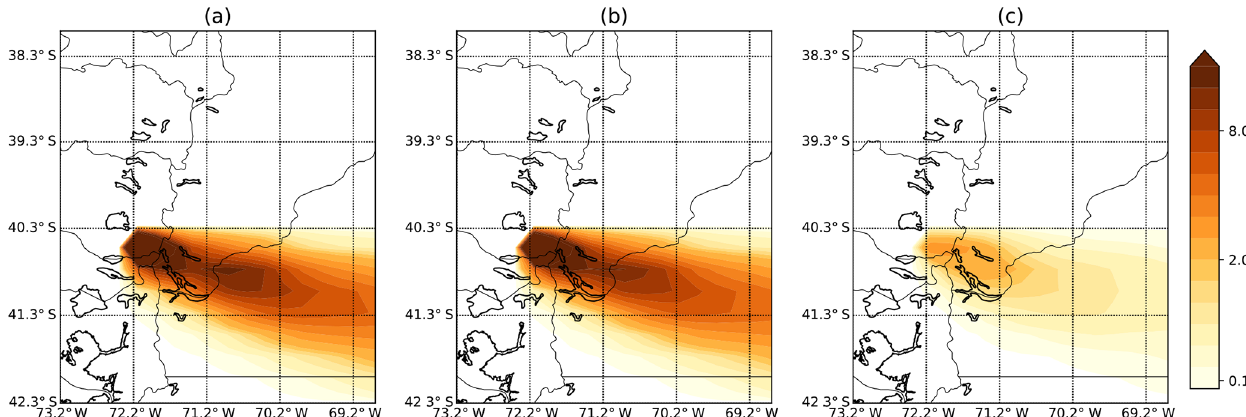
Figure 10. (a) Nature run ash concentration at flight level 200 (shaded, 10 − 3 gm − 3 ); (b) as in (a) but for the 6h forecast of ash concentration initialized from the CONTROL analysis experiment; (c) as in (b) but for the CONTROL-NOEST experiment, corresponding to the 12th assimilation cycle.